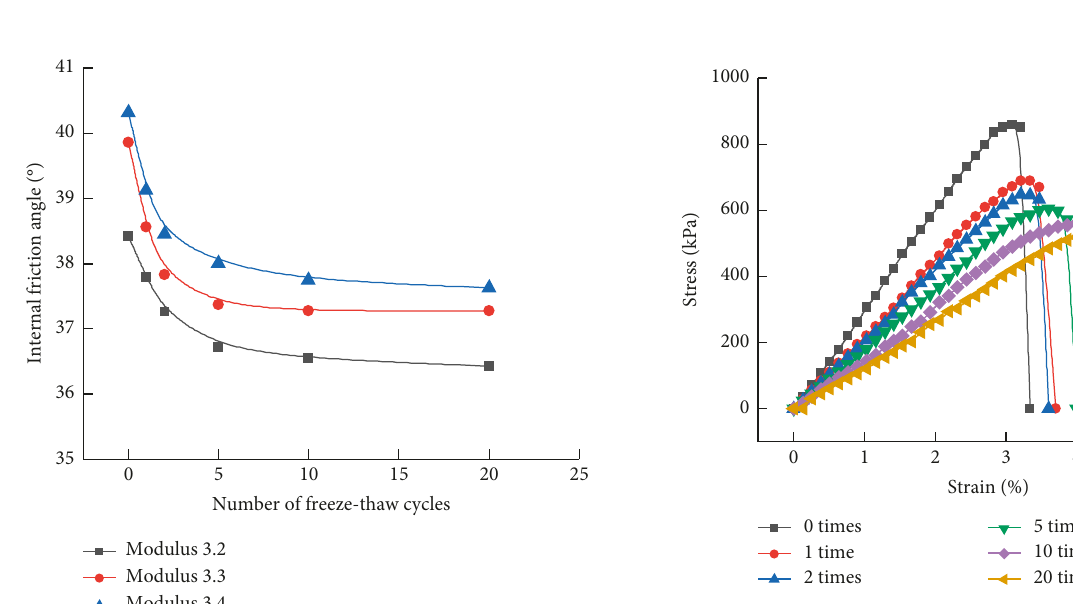
Figure 5: Stress changes with strain: modulus